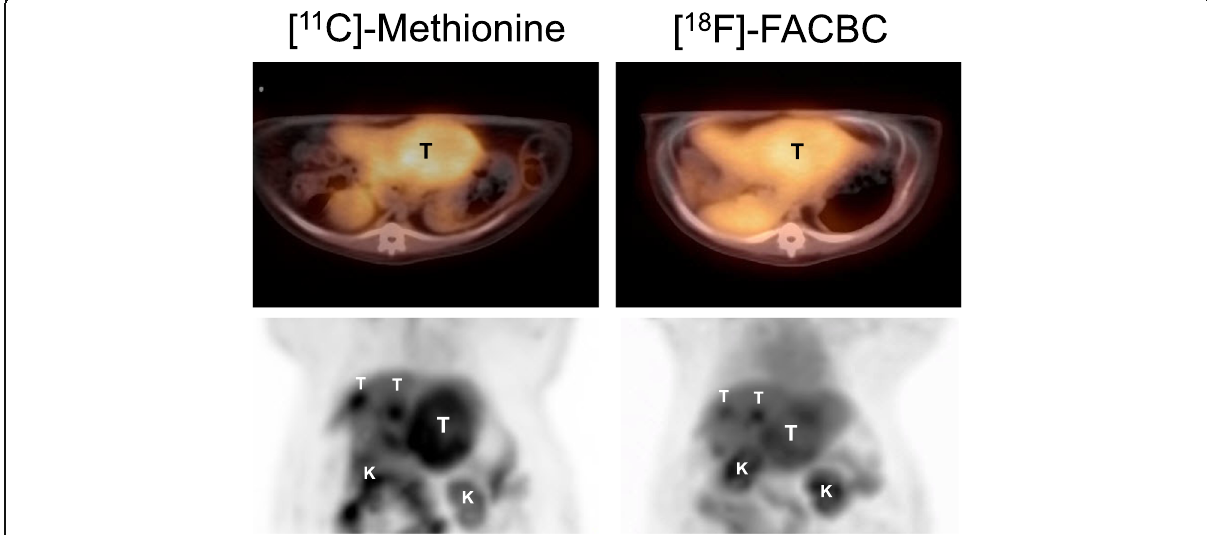
Fig. 5 Comparison between [ 11 C]Met and [ 18 F]FACBC for PET imaging of HCC taken between 15 and 20min post-injection. Top: PET/CT overlay (axial view). Bottom: maximum intensity projection (MIP, coronal view). T tumor (the large tumor in one lobe, also shown on the axial view, and two smaller tumors in a lobe behind); K